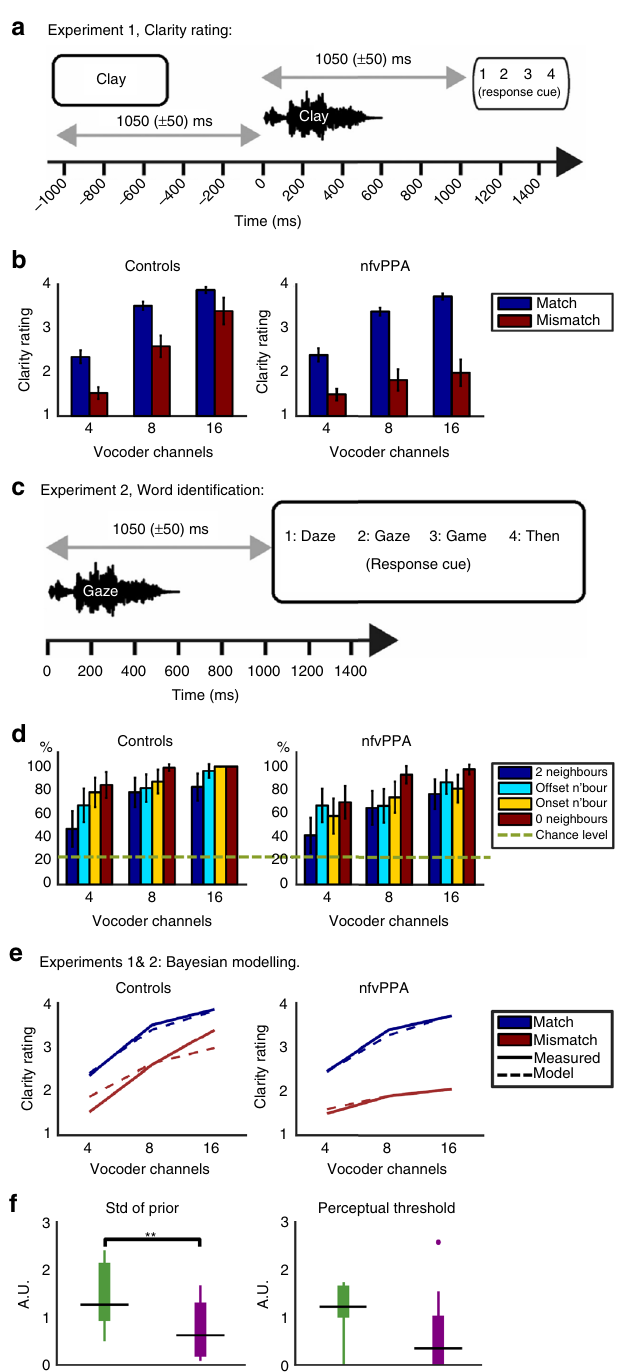
Mismatch trial, the written and vocoded words would share no phonology (for example the written cue ‘ clay ’ might be paired with the vocoded word ‘ sing ’ ). b Group-averaged clarity ratings for each condition. Error bars represent standard error across individuals within each group. c Four alternative forced choice vocoded word identi fi cation task. d Group- averaged per cent correct report for each condition. Chance performance at 25%. Error bars represent standard error across individuals within each group. e Overall group fi ts for single subject Bayesian data modelling of the data from b . f Derived parameters from the Bayesian data modelling. A.U., arbitrary units. Patients with nfvPPA displayed signi fi cantly more precise prior expectations than controls (Wilcoxon U (11,11) p < 0.01). They also displayed a trend towards a reduction in perceptual thresholds (Wilcoxon U (11,11) p =